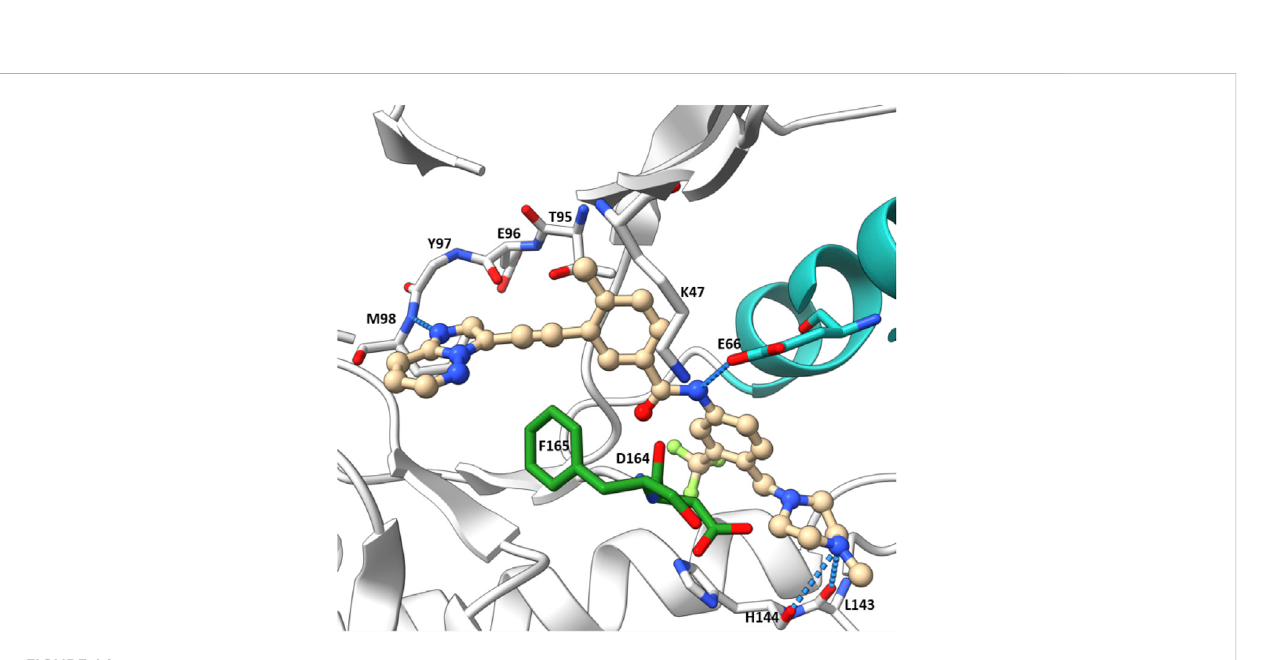
Co-crystal structure of ponatinib and RIPK2 (PDB ID: